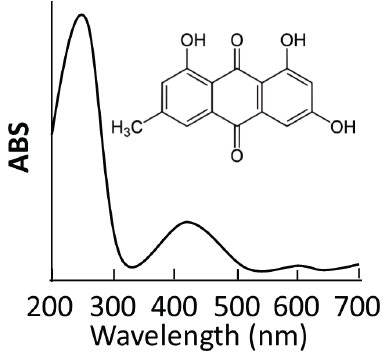
Figure 3. UV-Vis spectrum and chemical structure of the emodin